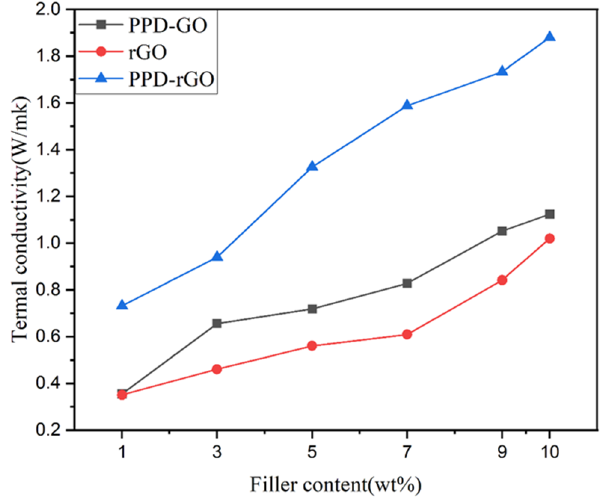
Figure 7. Thermal conductivity diagram of composite materials.